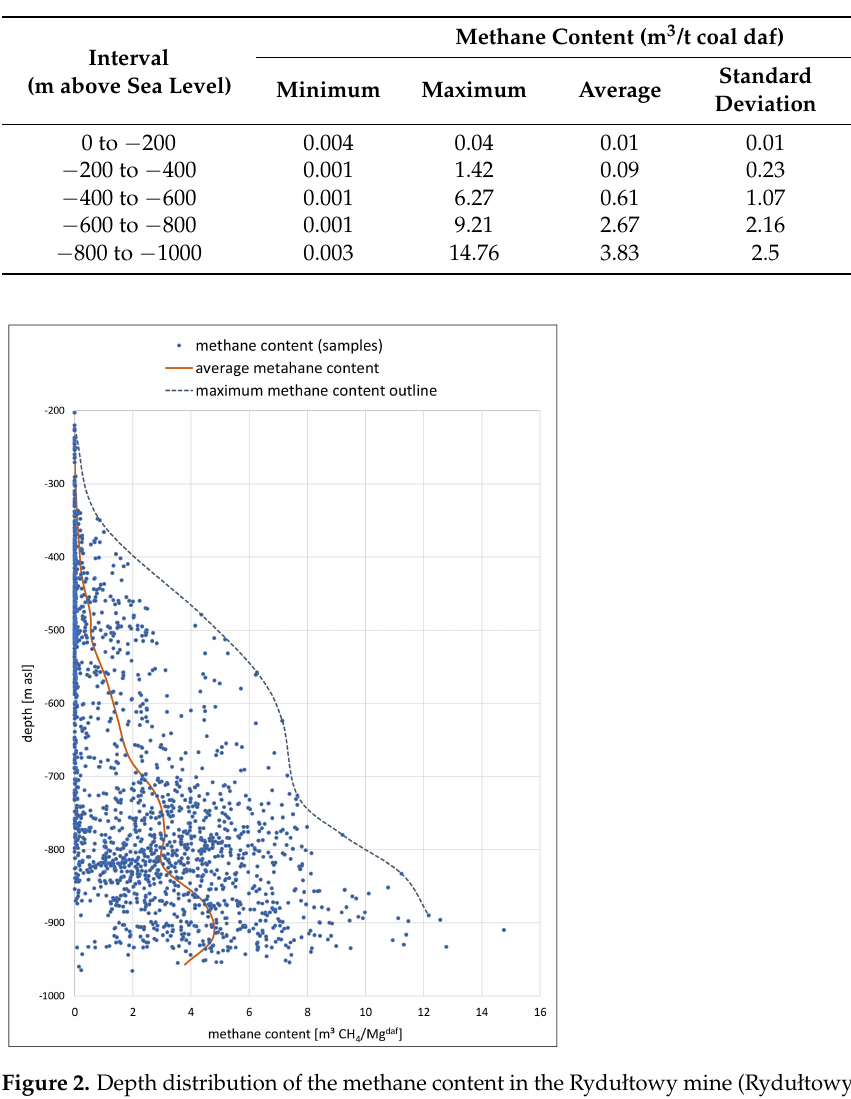
Figure 2. Depth distribution of the methane content in the Rydułtowy mine (Rydułtowy mine archive